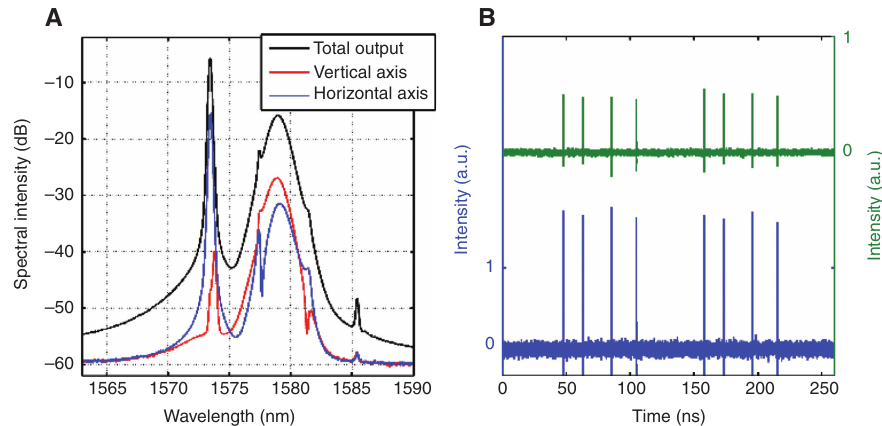
Figure 3: Dual-wavelength operation of the gain-guided dissipative soliton fiber laser: continuous wave and vector gain-guided dissipative soliton.